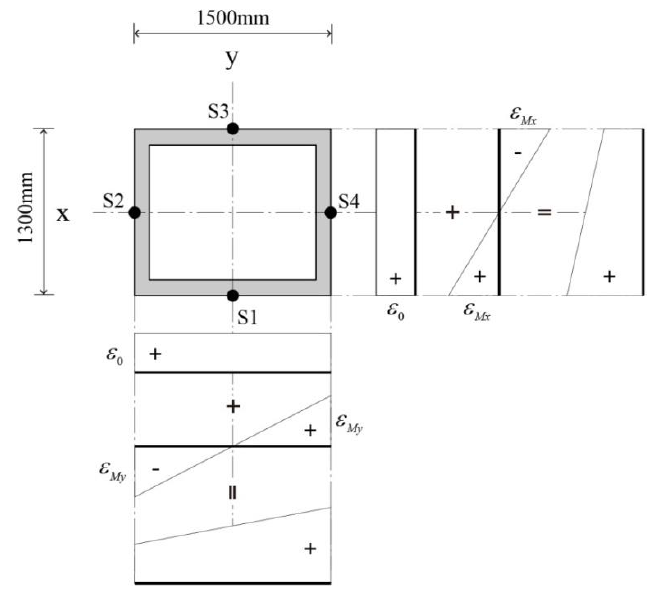
Figure 4. Stress distribution of the mega column subjected simultaneously to an axial force and bending moments.